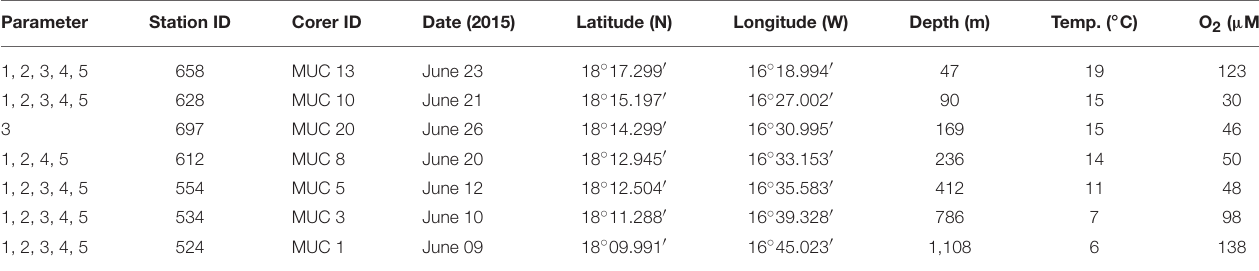
TABLE 1 | Sampling stations along the depth transect at 18 ◦ N off Mauritania, with five replicate cores used for the determination of (1) porewater geochemistry, (2) sediment properties, (3) bioirrigation, (4) N 2 fixation and molecular microbiology, and (5) sulfate reduction.